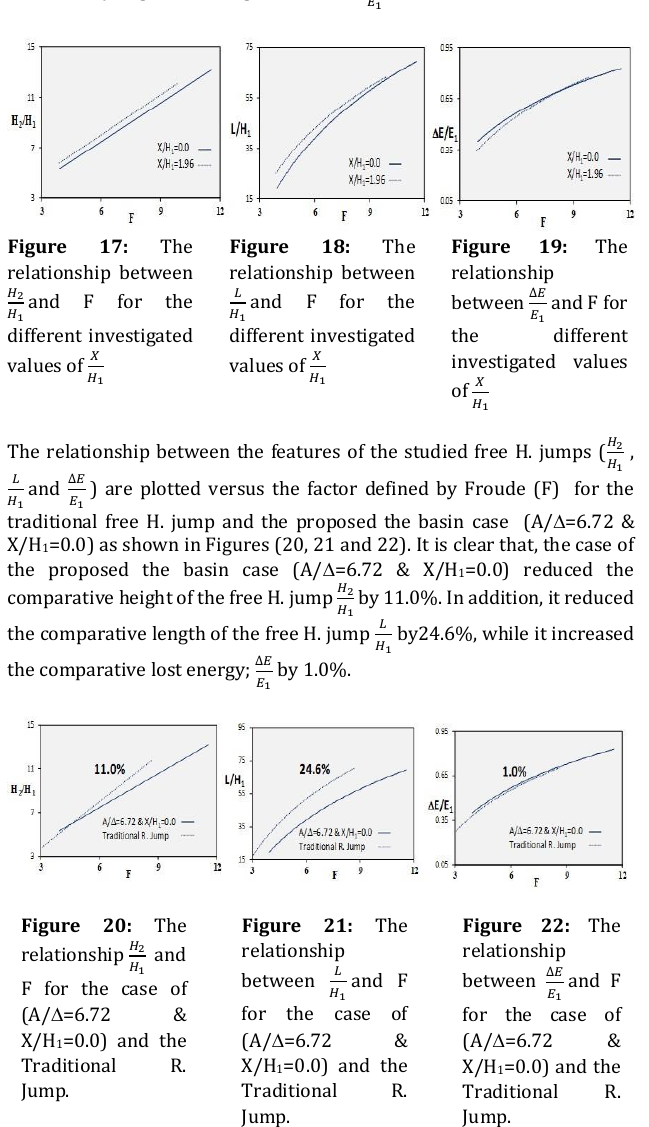
Figure 14: The relationship between 𝐻 2 and F 𝐻 1 for the different investigated values of 𝐴 ∆